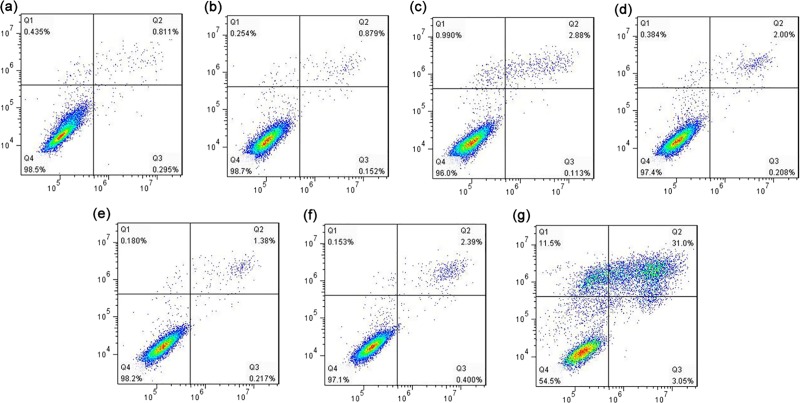
Flow cytometry analysis of apoptosis in T. thermophila.(a) Blank control; (b) negative control (NC) and koumine added at (c) 0.05 mg/mL; (d) 0.1 mg/mL; (e) 0.2 mg/mL; (f) 0.4 mg/mL and (g) 0.8 mg/mL. Q1: necrotic cells; Q2: late stage apoptotic cells; Q3: early stage apoptotic cells; Q4: living cells.